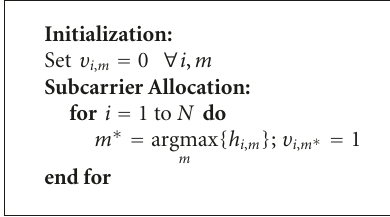
Algorithm 1: Subcarriers to user